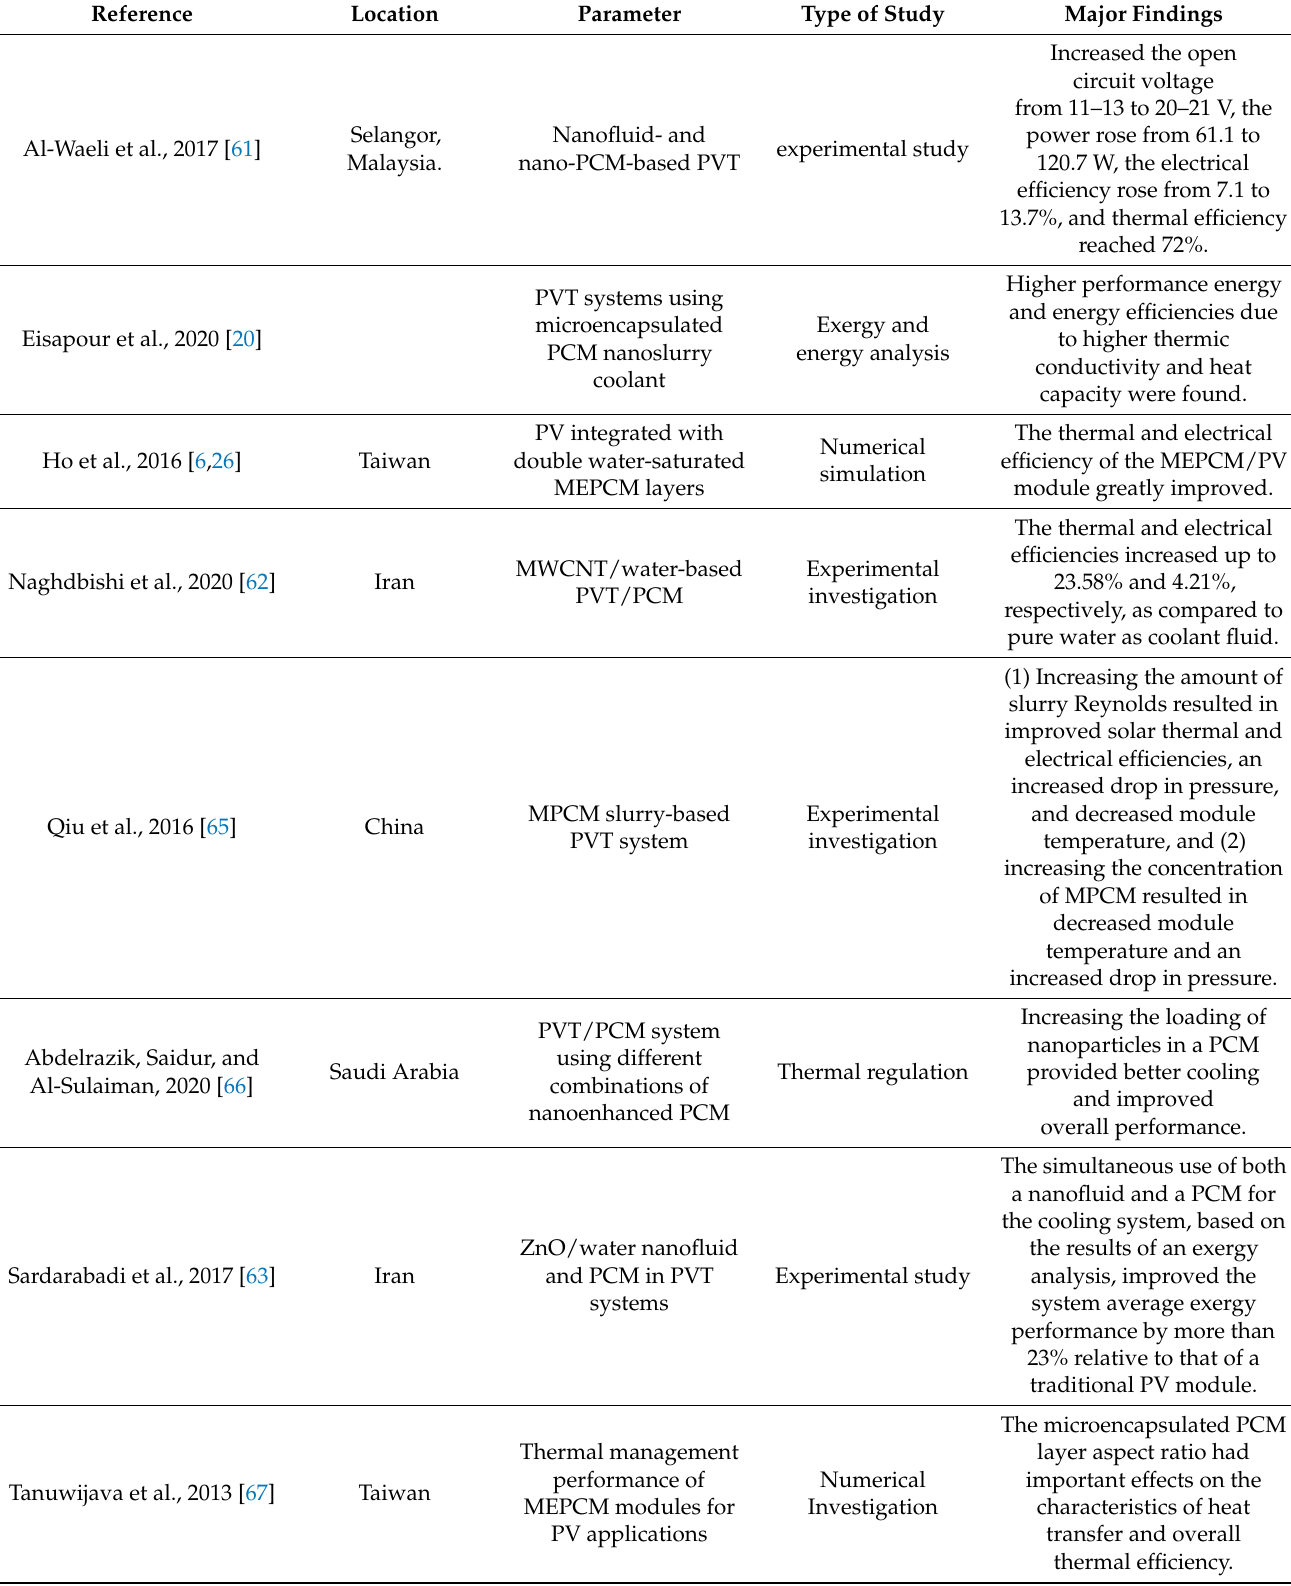
Table 2. Summary of the studies reviewed herein on PVT cooling using nanofluids and